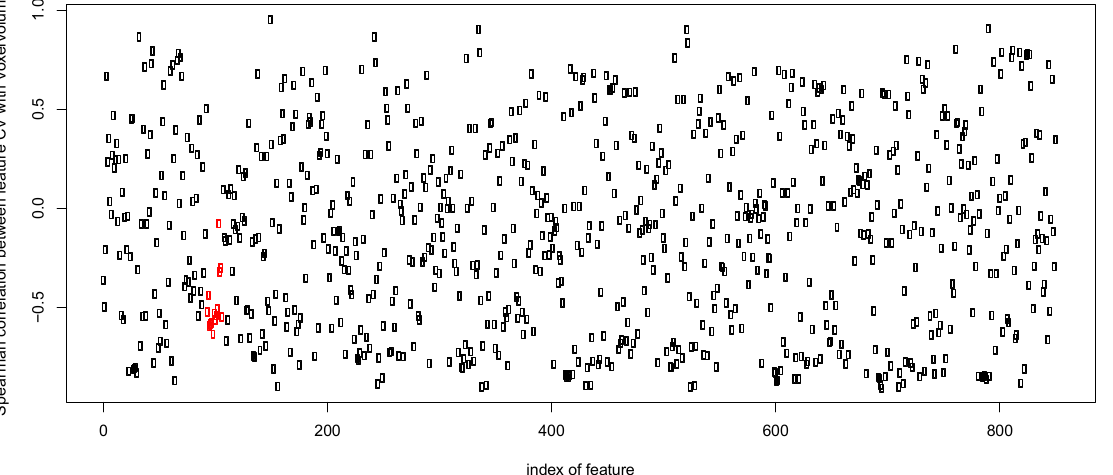
Figure 16. Correlation between CV for each feature (on x -axis) and lesion size (shape feature Voxel Volume). Spearman method was used. Red circles indicate correlation for ‘shape’ features; only a weak correlation exists.